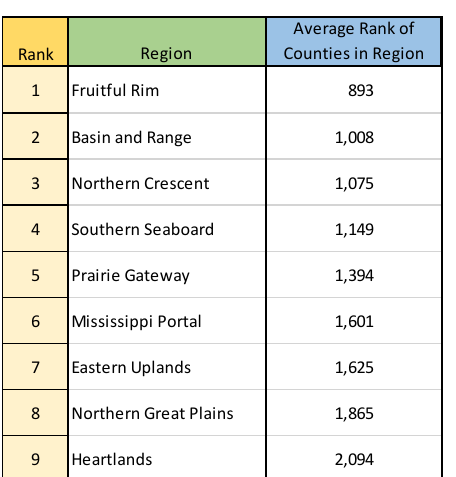
Table 8. Region Ranking, Female Principal Operators, 2012 Map 7. Female Principal Operators Rank, 2012